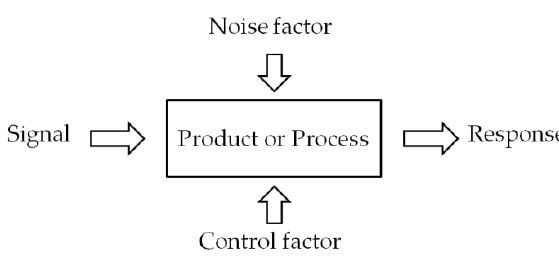
15 Table 2. Orthogonal array L 18 (2 1 × 3 3 ) . Exp. No.